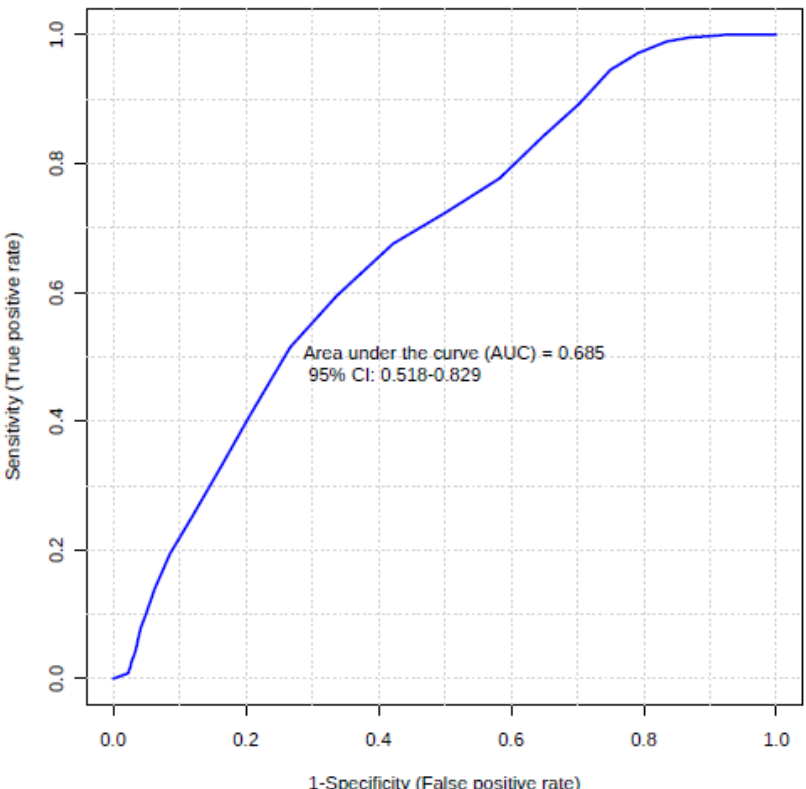
Figure 6. Plot of the multivariate ROC curve for the created biomarker model based on three variables (sTNF ‐ R1, MMP ‐ 3, sCD30/TNFRSF8).